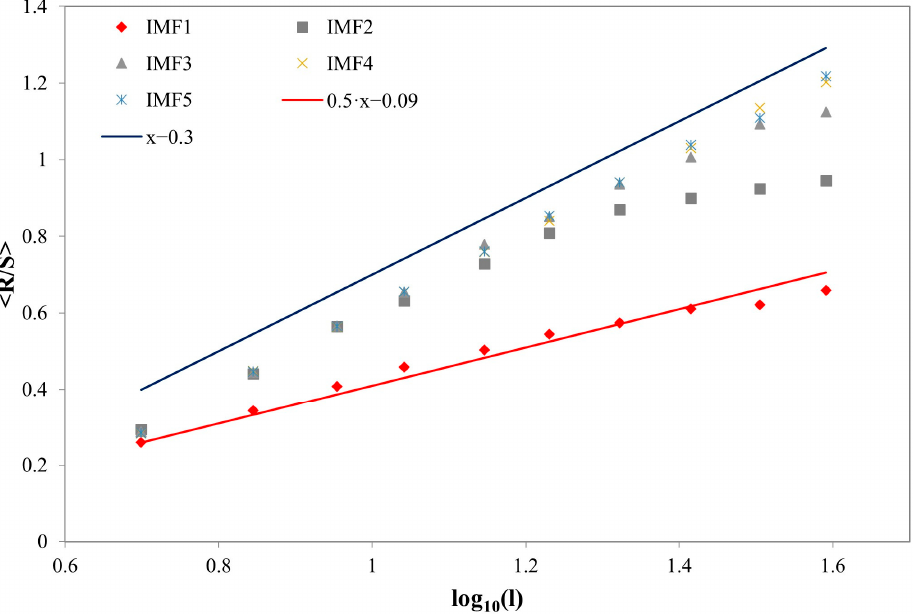
Figure 13. Hurst analysis for the deseasonalized and detrended reconstructed water table depth timeseries.